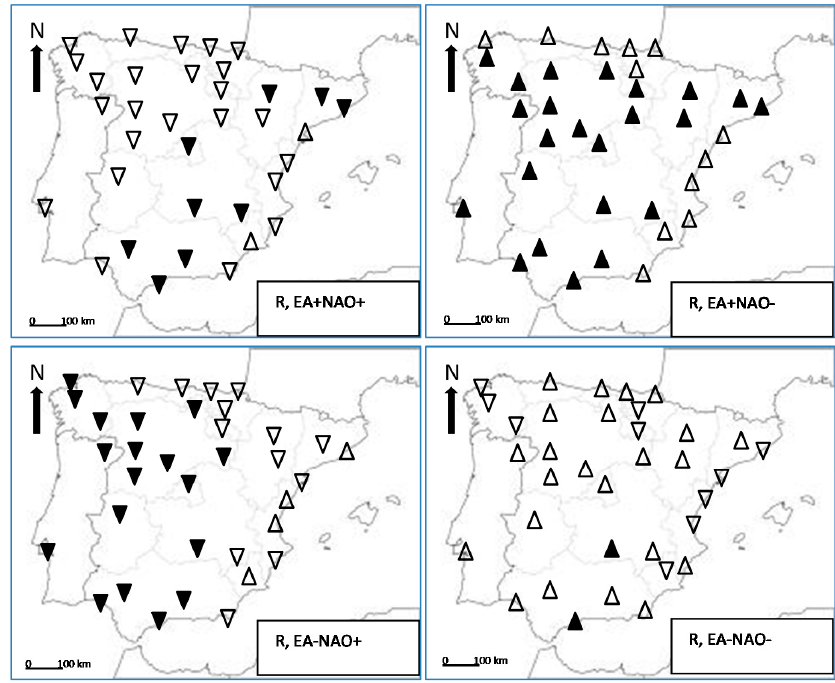
Figure 3. Difference of R mean values for each EA-NAO composite and the mean of the complete period 1950–2019 for winter. Triangle up (down) means positive (negative) difference, full (empty) triangle means significant (not significant) difference at the 95% confidence level.